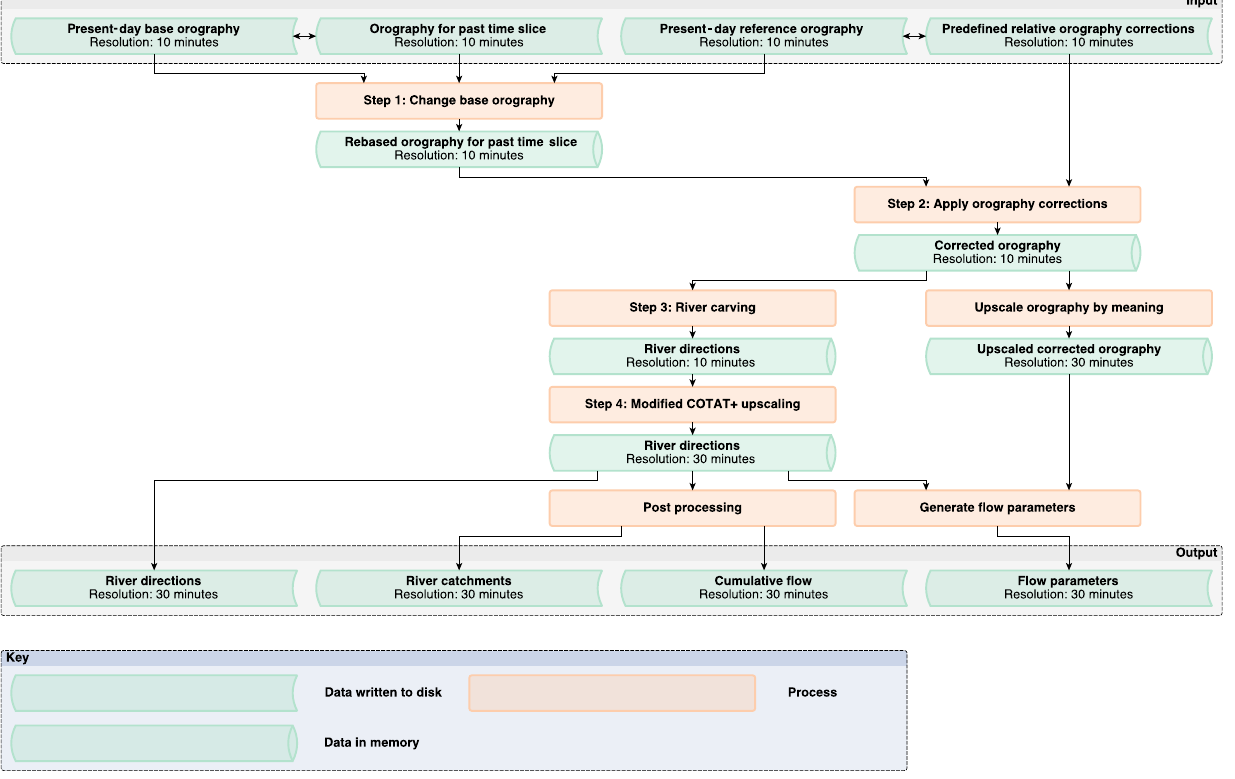
Figure 1. Flow diagram illustrating the steps of the method presented here for generating river directions and flow parameters for dynamic hydrological discharge modelling. (Here, “upscale orography by meaning” means simply taking the mean value of the nine 10min DEM cells contained within the area covered by each 30min DEM cell as the value of that 30min DEM